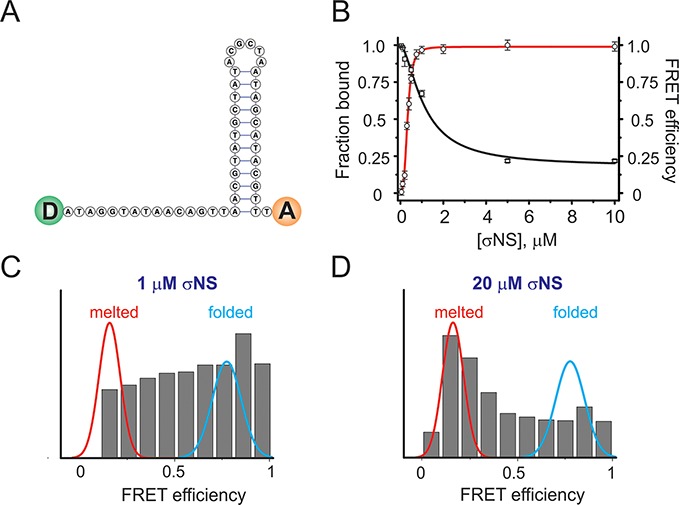
σNS binding to partially double-stranded nucleic acids results in helix-unwinding. (A) A minimum folding energy structure of a 46-nt long stem-loop used for helix unwinding assays. FRET donor and acceptor pair is schematically shown as green and orange circles at the 5′ and 3′ ends, respectively. (B) Binding of σNS to the stem-loop shown in (A), monitored by FA (red binding curve fit), with Kd of 333 ± 10 nM. The second fit (in black) shows changes in ensemble FRET upon σNS binding to the stem-loop due to helix unwinding (apparent Kd = 1.1 ± 0.2 μM). (C) Multiple unwound stem–loop intermediates, revealed by the wide distribution of the smFRET population histogram of the stem-loop probe (10 pM), incubated with 1 μM σNS. Gaussian fits of data for formamide-melted (red, low FRET) and heat-annealed (folded, cyan, high FRET) probes are overlaid for reference. (D) smFRET population histogram of the 46-nt stem-loop (as shown in C), incubated with 20 μM σNS.